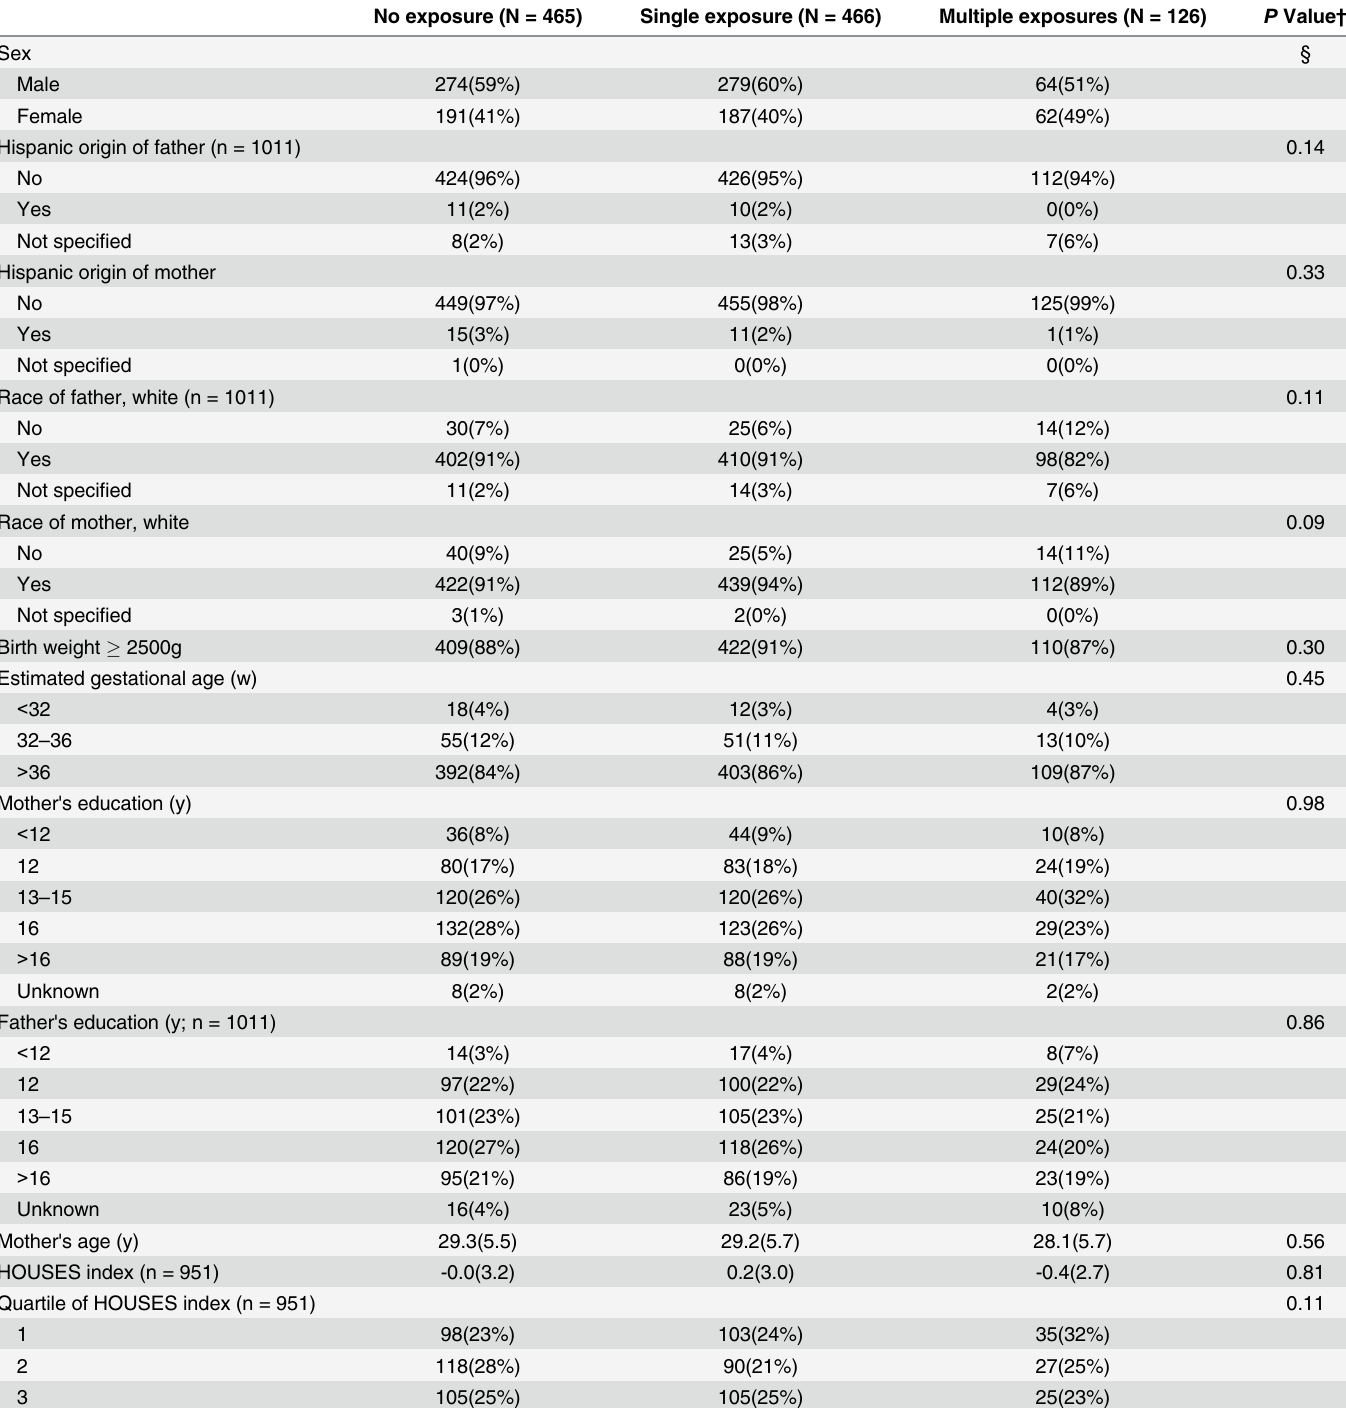
Table 2. Characteristics of the study cohort consisting of multiply exposed, singly exposed, and unexposed children (n = 1057).